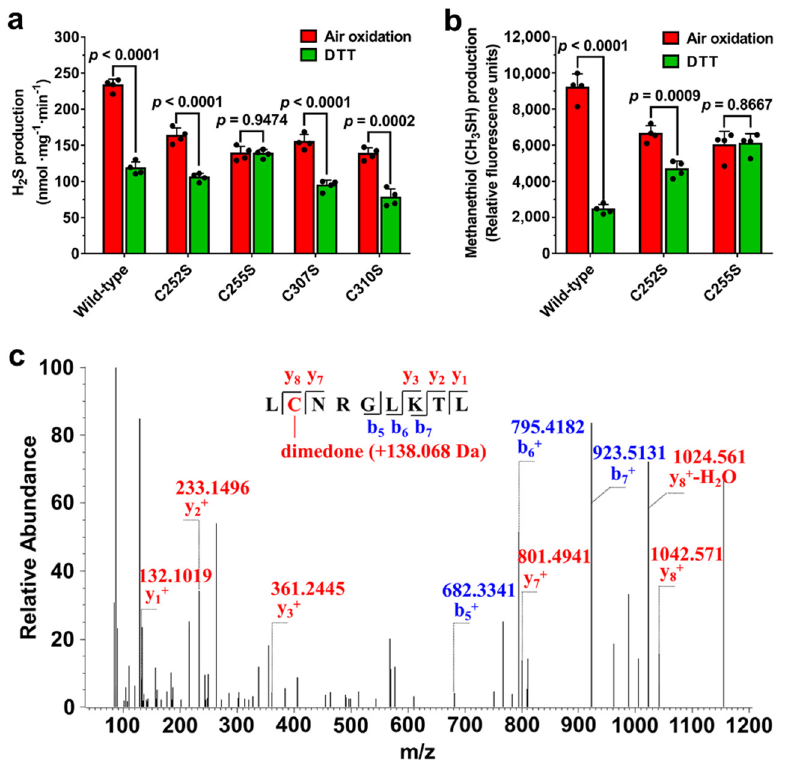
Figure 2. Sulfenic acid modification of the residue Cys255 is crucial for oxidation sensing. ( a , b ) Re- combinant wild-type or mutant CSE was treated with 10 mM DTT. The samples were then ultrafil- tered to remove DTT and exposed to air oxygen for 1 h at room temperature by gently pipetting up and down. CSE activity was measured using 20 mM L-cysteine ( a ) or 10 mM S -methylcysteine ( b ) dent’s t test was used to determine the significance of differences between two group means. ( c ) LC- MS/MS analysis indicates the formation of the dimedone adduct (+138.068 Da) of sulfenic acid in